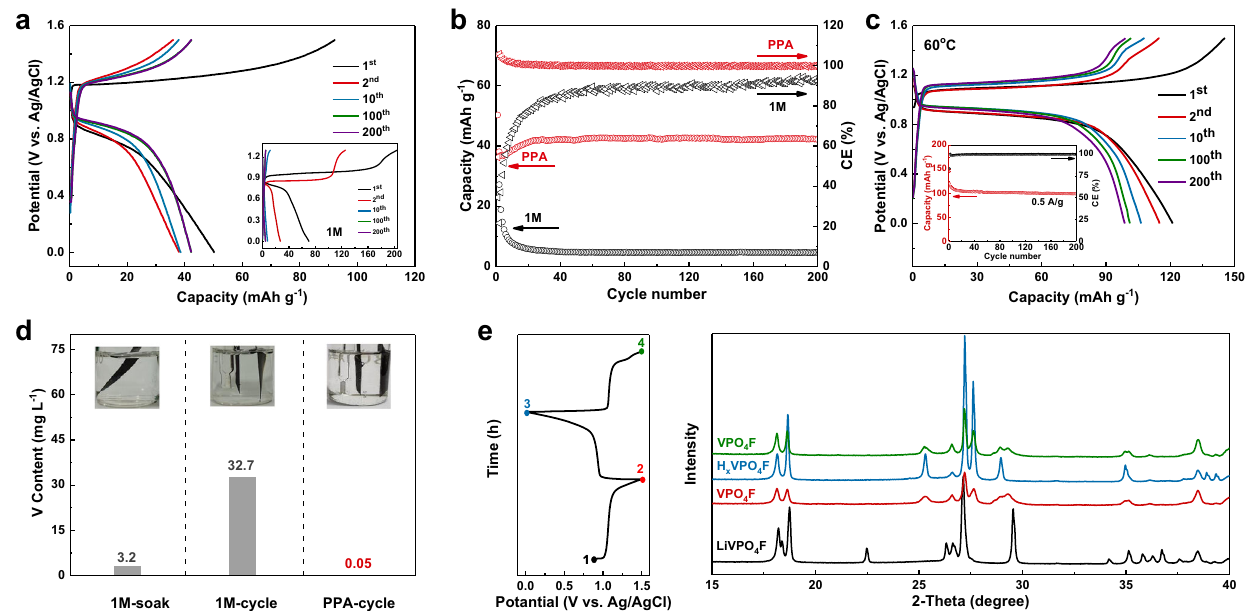
Fig. 3 | Characterization investigations and electrochemical performance of LVPFcathode.a , b Thecomparisonofvoltagepro fi lesandcyclingperformanceof LVPF that cycled in the 1M H 3 PO 4 and PPA electrolytes at a current density of 0.2Ag − 1 at 25°C. c The electrochemical performance of LVPF cycled at a current density of0.5Ag − 1 at 60°Cin PPA electrolyte. d The concentrations of dissolvedV